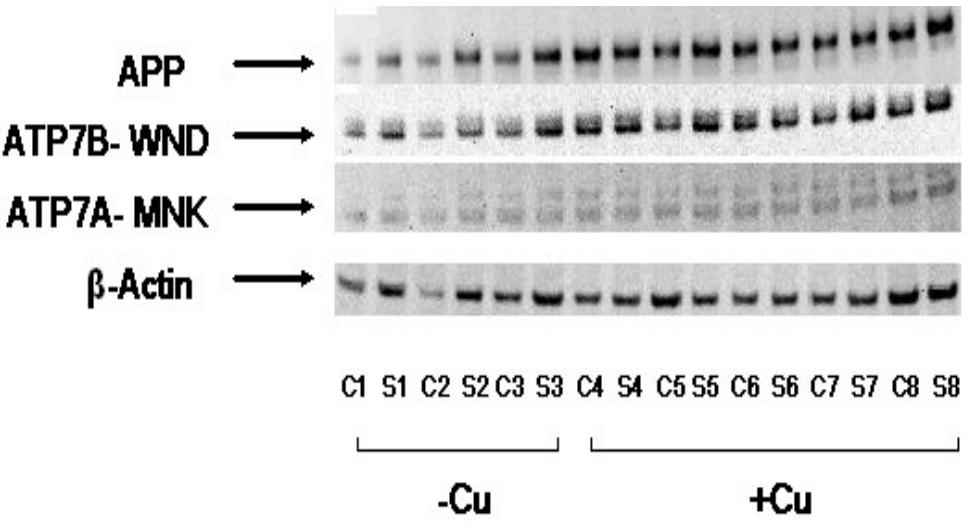
Figure 4. Cu treatment increased APP protein expression in APP/PS1 transgenic mouse brain (A) The protein levels of APP, Cu(II)-ATPases- APT7B/WND and ATP7A/MNK, and the control protein- β- actin in lysates were probed by Western blotting. These cortical (C) and striatum (S) tissue lysates were collected from regular food-fed APP/PS1 transgenic mice (3) and mice fed by Cu-enhanced chow (5).